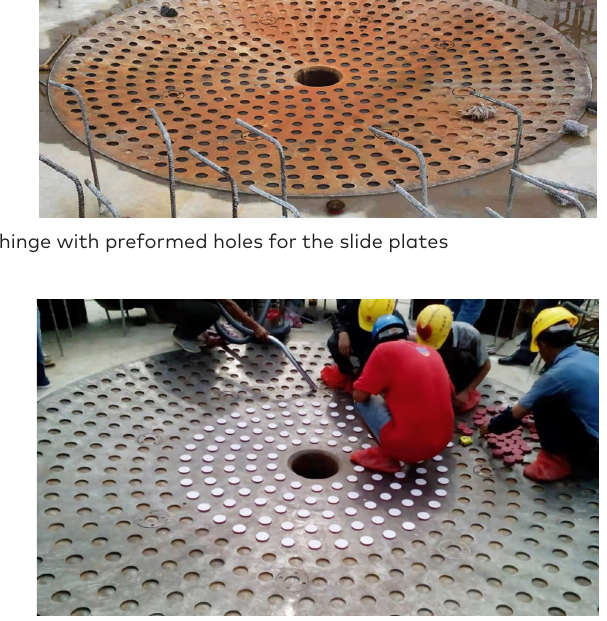
Figure 3. Slide plates distribution on the surface